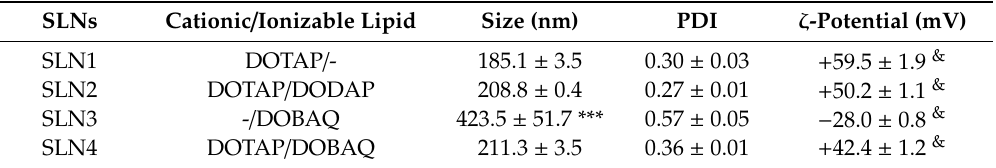
Table 1. Physical characterization of solid lipid nanoparticles (SLNs). SLNs